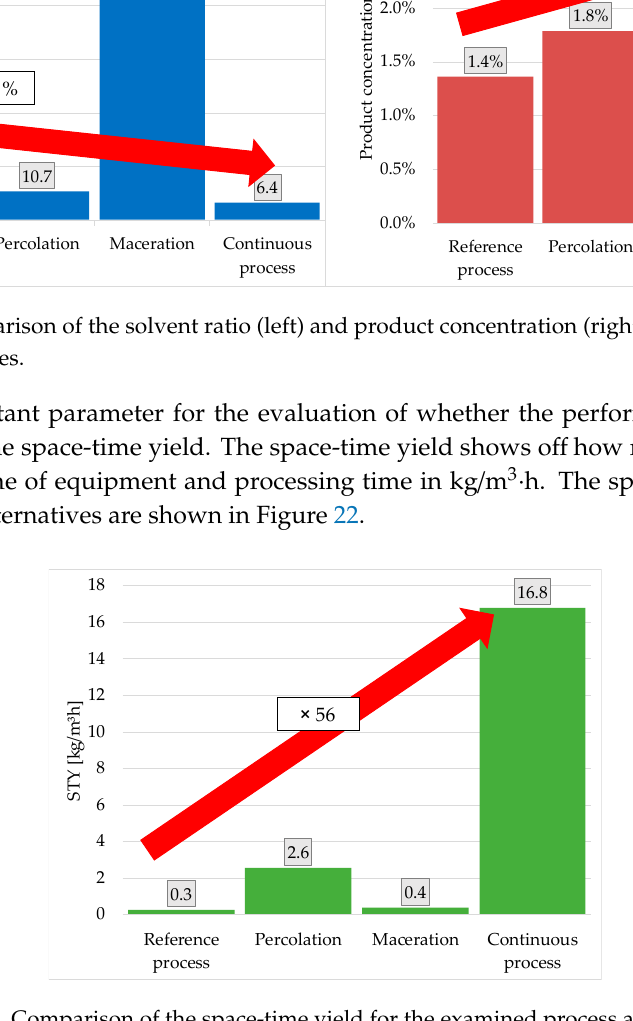
Figure 20. Scheduling for a continuous extraction process with a two-column concept.